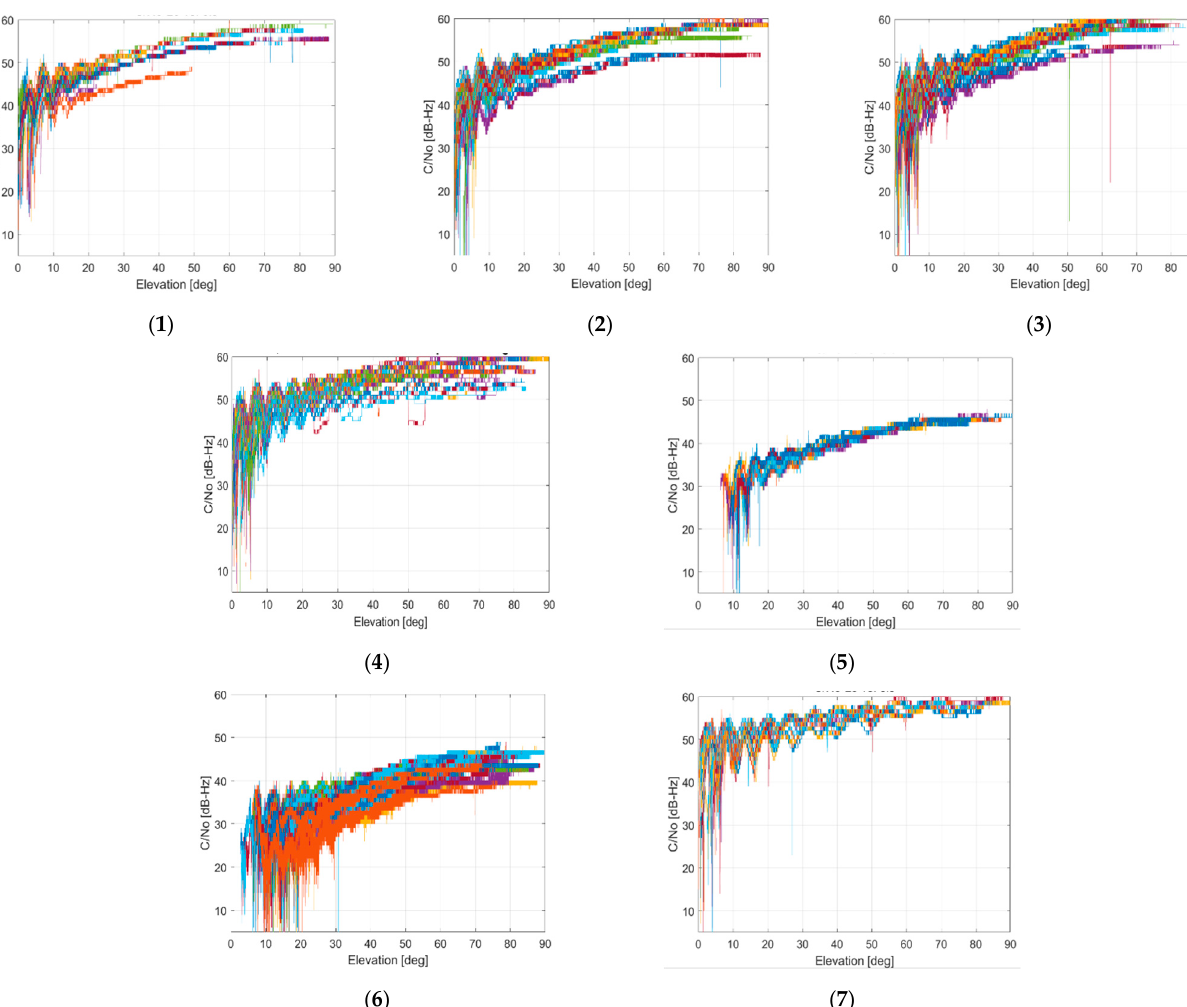
Figure A12. C/N0 at L5/E5a for the antennas measured at DLR; from left to right, from top to bottom: ( 1 ) Leica AR25 R4; ( 2 ) Novatel GNSS-750; ( 3 ) Javad RingAnt-DM; ( 4 ) Space Engineering GalExpAnt; ( 5 ) DLR internal design; ( 6 ) Navxperience Nav3G+C; ( 7 ) Tallysman VSE6028 VeroStar. Different colors indicate different PRNs.